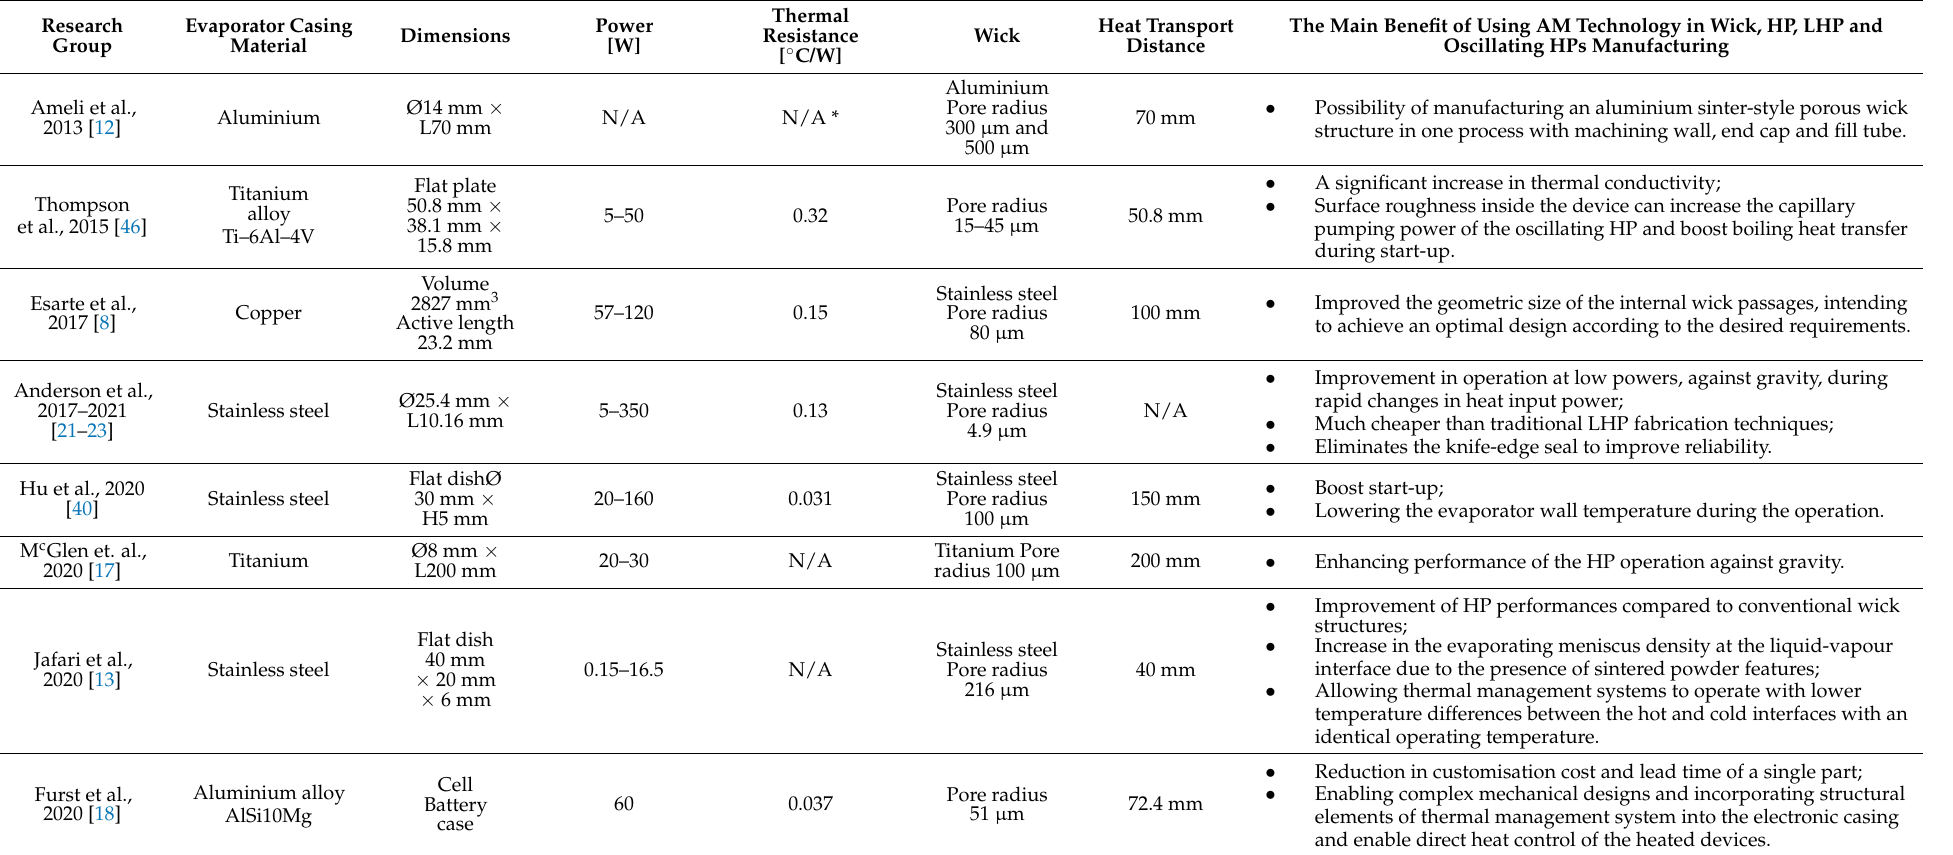
Table 1. Comparison between developments of using AM technique in manufacturing wicks, HP’s, LHPs and oscillating